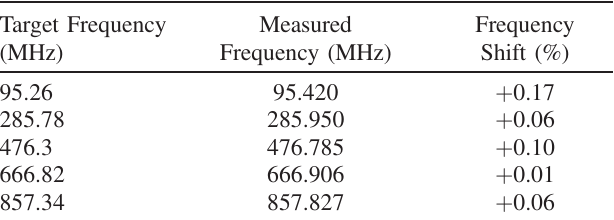
TABLE II. Resonant frequency measurements.